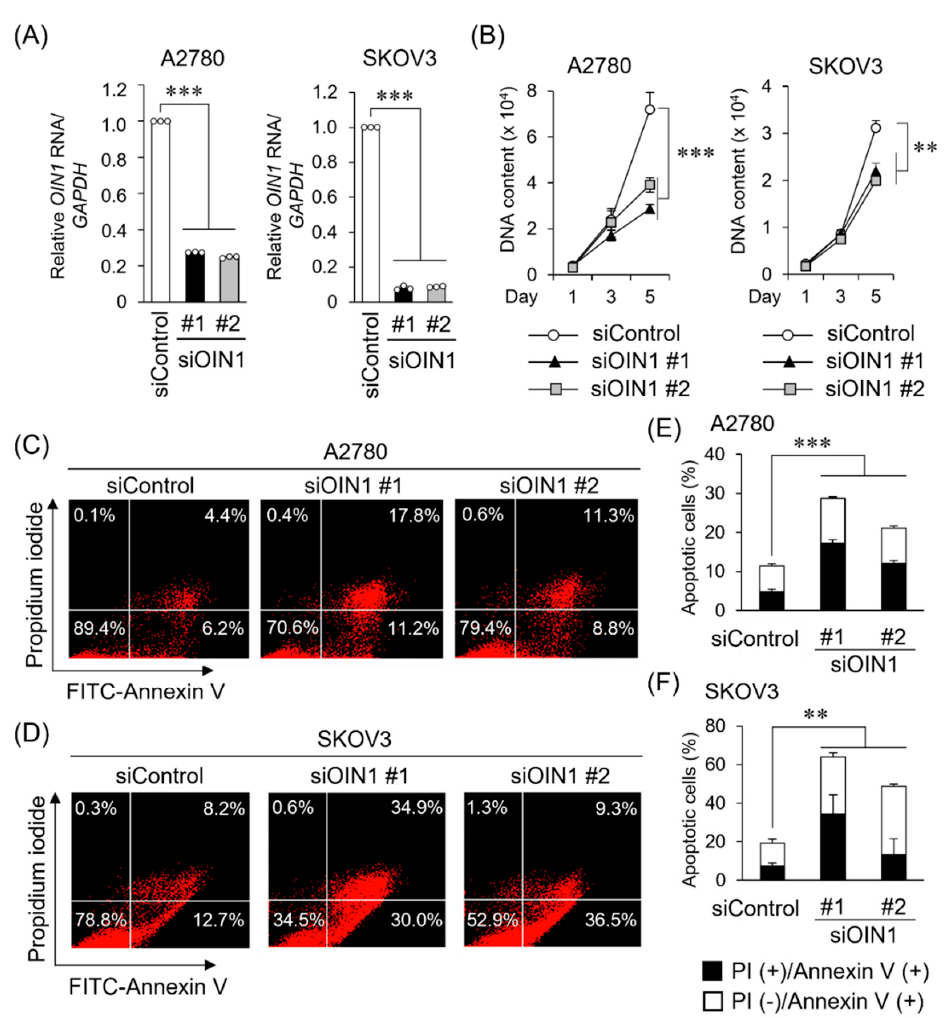
Figure 2. OIN1 regulates proliferation and apoptosis in ovarian cancer cells. ( A ) Knockdown efficiencies of siRNAs targeting OIN1 (siOIN1 #1 and #2) in A2780 and SKOV3 cells 48 h after siRNA transfection were analyzed by qRT-PCR. Relative OIN1 RNA expression levels were normalized to GAPDH mRNA levels and presented as mean fold change ± SD compared with control siRNA (siControl) in each cell type ( n = 3). ( B ) Inhibitory effects of OIN1 knockdown in A2780 and SKOV3 cell proliferation were analyzed by DNA assay. Data are presented as mean ± SD (A2780, n = 5; SKOV3, n = 3). ( C – F ) Promoting effects of OIN1 knockdown in apoptosis of A2780 ( C ) and SKOV3 ( D ) cells 72 h after siRNA transfection were analyzed by flow cytometry with propidium iodide and annexin V. Percentages of annexin V-positive populations of A2780 ( E ) and SKOV3 ( F ) cells treated with indicated siRNAs were quantified ( n = 3). ** , p < 0.001; *** , p < 0.0001, two- way ANOVA.